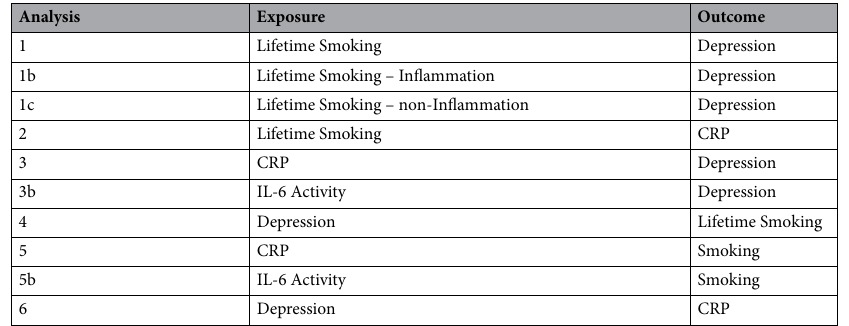
Table 2. Univariable MR analyses performed in this report. Analyses 1, 2, and 3 are the main analyses in this report and the rest are considered supplemental. Analyses 4, 5, and 6 are the reciprocal MR analysis for 1, 2, and 3, respectively. Analyses 1b, 1c, and 3b include biological factors in the IV selection. Analyses 3b and 5b correspond to those performed using IL-6 activity.